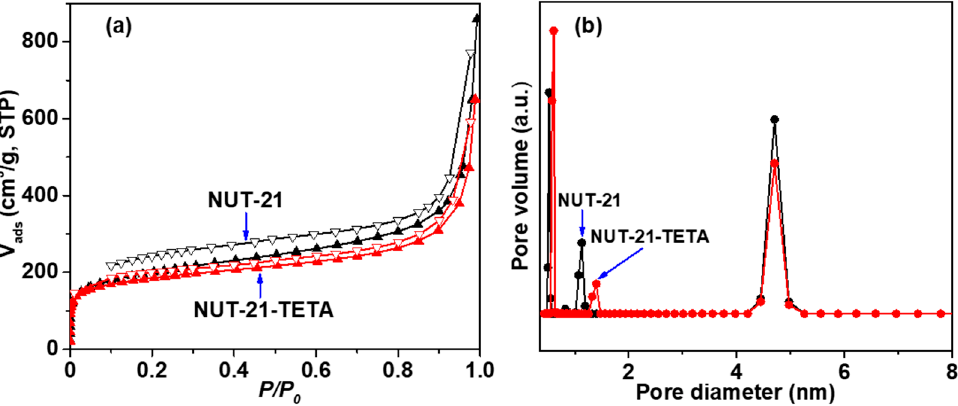
Figure 5. ( a ) N 2 adsorption–desorption isotherms and ( b ) corresponding pore size distributions of the NUT-21 and NUT-21-TETA.